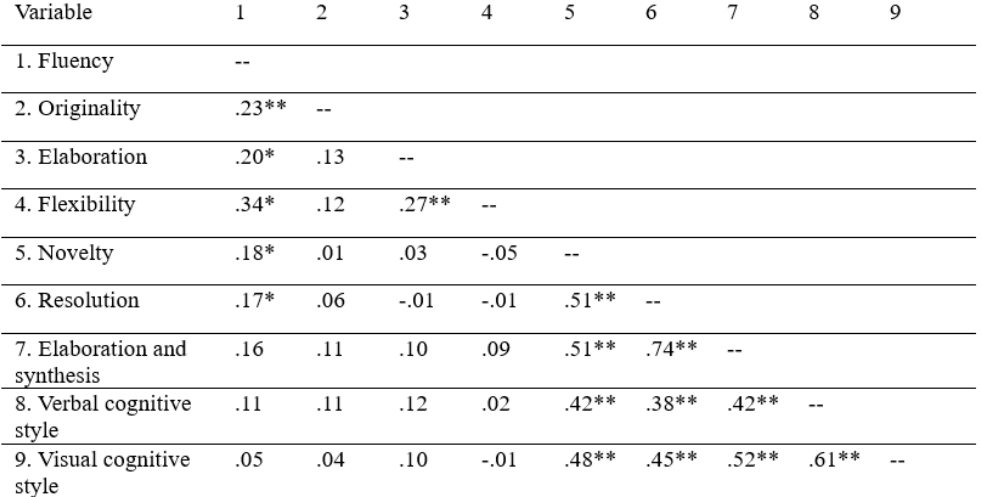
Table 1. Pearson correlation coefficients among nine variables.